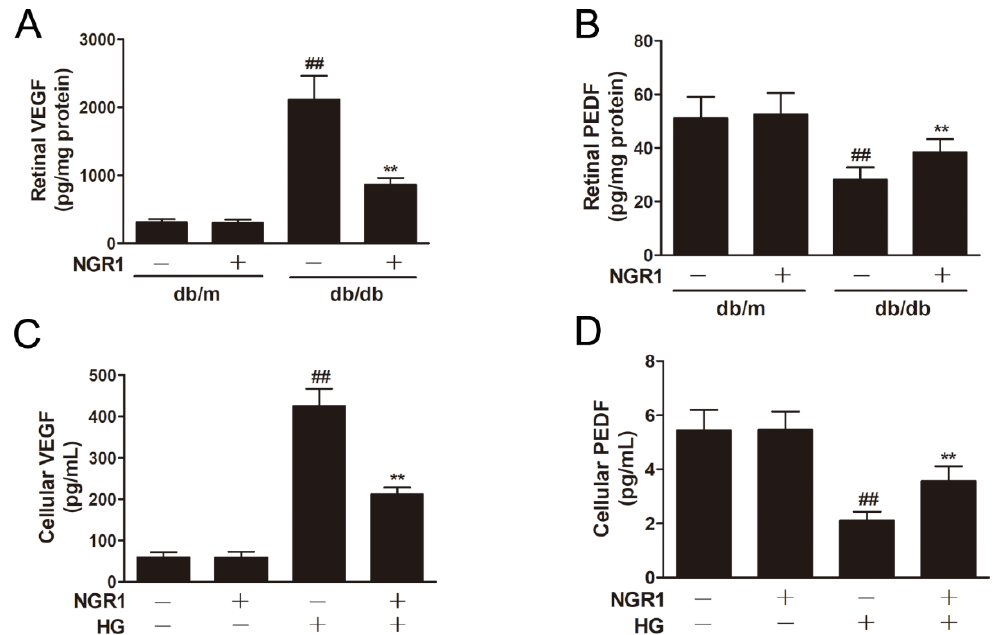
Figure 4 . NGR1 pretreatment significantly attenuated the levels of VEGF and PEDF in vivo and in intro. The levels of VEGF ( A ) and PEDF ( B ) in retinas of db/db mice were determined by ELISA. The levels of VEGF ( C ) and PEDF ( D ) in HG ‐ induced rMC cells were determined by ELISA. The results are expressed as the means ± SD (n = 10). Two groups were analysed by unpaired two ‐ tailed Student’s t tests, and multiple groups were analysed by one ‐ way analysis of variance (ANOVA); ## indicates a significant difference from control cells or db/m mice ( p < 0.01). ** indicates a significant difference from the HG treatment or db/db mice ( p < 0.01). (+), treatment with HG or NGR1; ( − ), treatment without HG or NGR1.